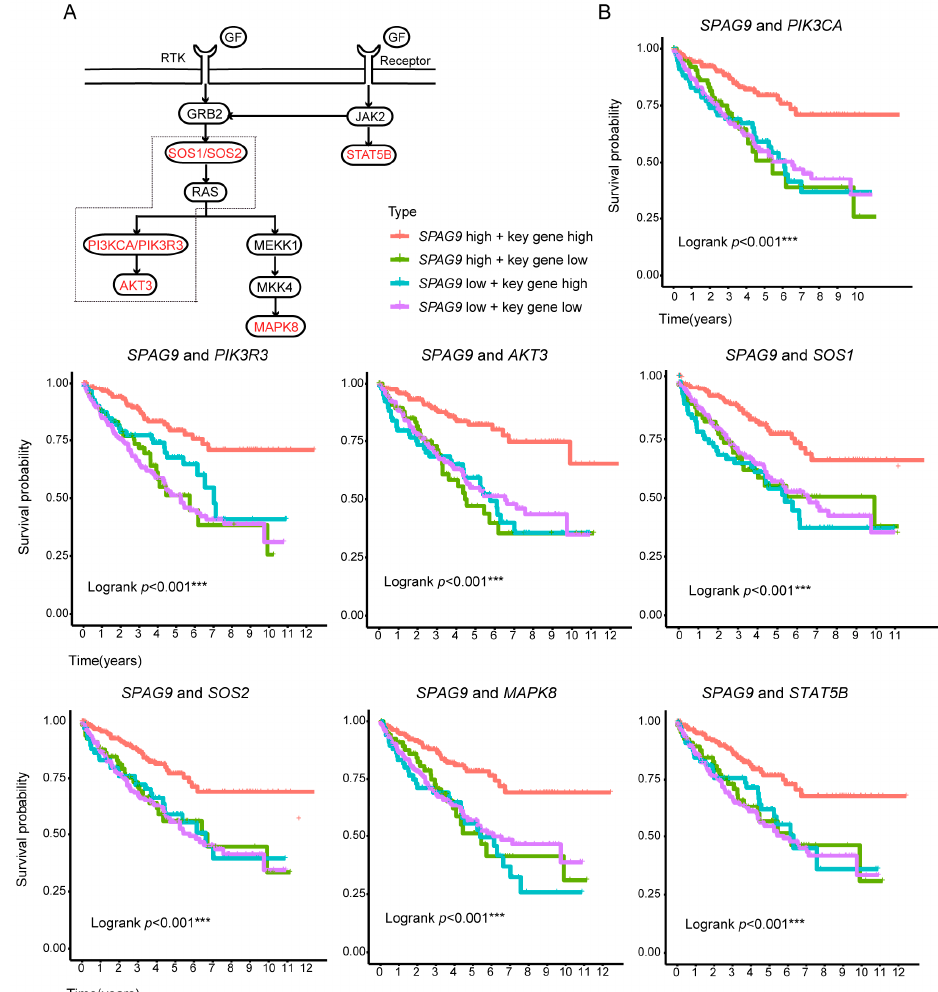
group and the low- SPAG9 -expression group), and GSEA analysis (in KEGG collection) was conducted, respectively. Each line represents one particular pathway with a unique color. At the bottom, genes up-regulated in a particular pathway are on the left of x-axis; by contrast, the down-regulated genes are on the right. Only pathways with |NES| > 2 and FDR p values ≤ 0.05 are shown. Top: the enriched pathways in the high- SPAG9 -expression group; bottom: the enriched pathways in the low- SPAG9 -expression group. ( B ) Scatter plots showing the correlation between the activity scores of the adipocytokine-signaling pathway ( left ), ERBB-signaling pathway (middle), and JAK-STAT-signaling pathway ( right ) and OS in ccRCC. ( C ) The activity scores of the adipocytokine-signaling pathway ( up ), ERBB-signaling pathway ( middle ), and JAK-STAT-signaling pathway ( down ) in tissues with different levels of malignancy. Normal: ccRCC paracancerous tissues; Long OS: ccRCC tissues from patients with longer OS (OS > median OS); Short OS: ccRCC tissues from patients with shorter OS (OS < median OS). ( D ) Univariate Cox analysis of the expression of SPAG9 and candidate genes in ccRCC. The selected key genes are marked in orange. * p value < 0.05, ** p value < 0.01, *** p value < 0.001.